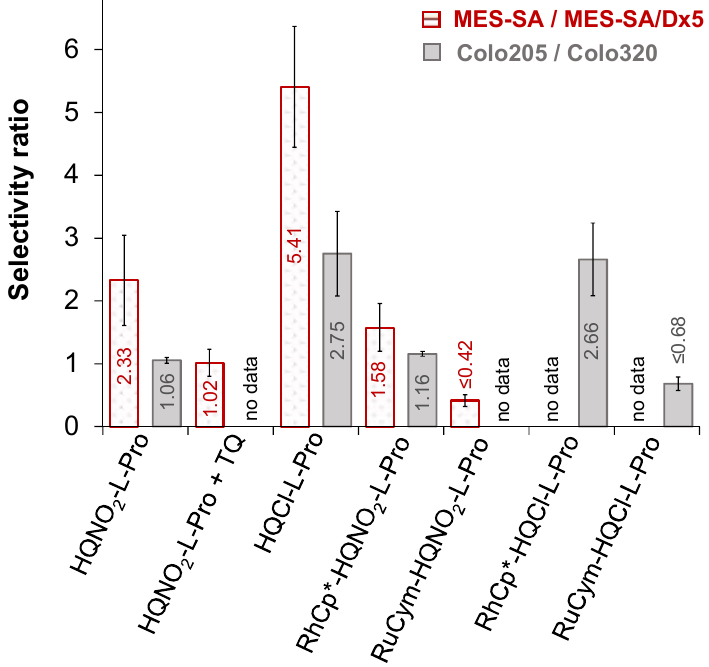
Figure 11. Selectivity ratios calculated on the basis of the IC 50 values in Table 4: IC 50 (MES-SA)/IC 50 (MES-SA/Dx5) (left, dotted columns) and IC 50 (Colo205)/IC 50 (Colo320) (right, grey columns) for the ligands HQNO 2 -L-Pro, HQCl-L-Pro and their RhCp* and RuCym complexes. Data for HQCl-L-Pro are taken from Ref. [12].